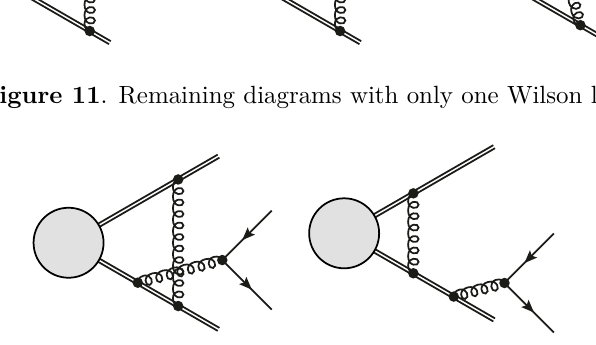
Figure 12 . Diagrams with two Wilson lines that correspond to scaleless integrals.